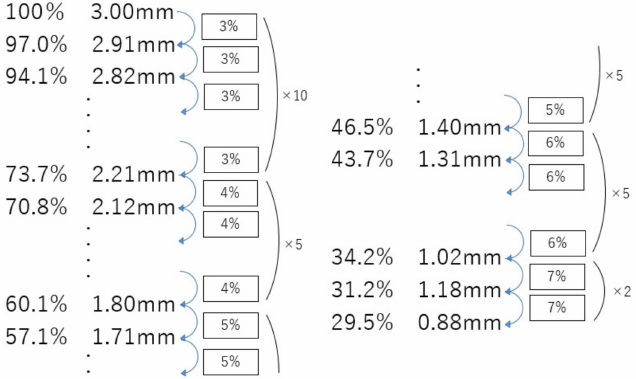
Figure 1. Schematic illustration of the carbon nanotube (CNT) dispersion process.